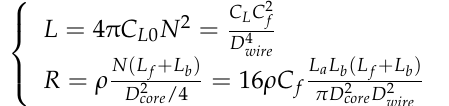
where C L 0 and C L were two parameters dependent on L a , L b , L f while independent of other variables and met C L = 64 C L 0 ( L a L b ) 2 / π ; ρ was the resistivity of copper.